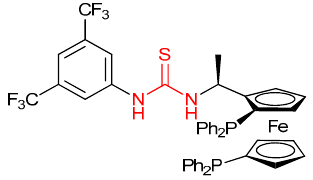
Figure 25. ZhaoPhos, a chiral bis-phosphine thiourea organocatalyst [309,310].